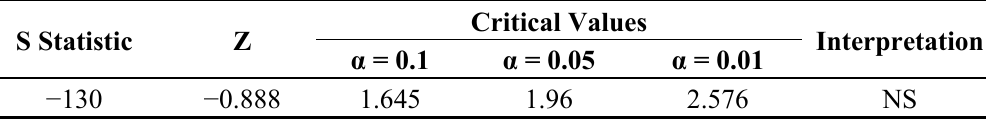
Table 2. Mann-Kendall test results of Huangfuchuan watershed.